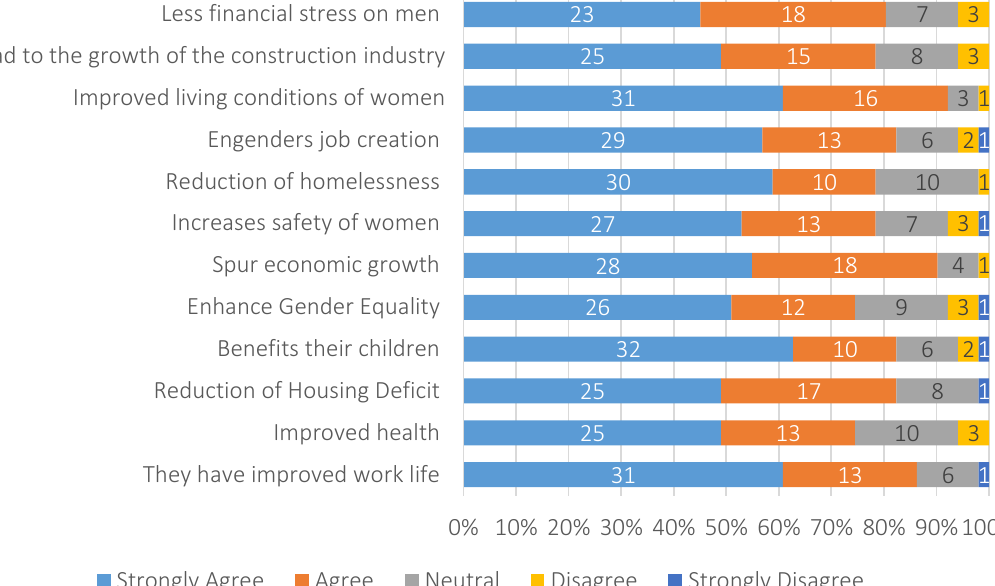
Figure 4. Benefits accrued when women can access building credits from